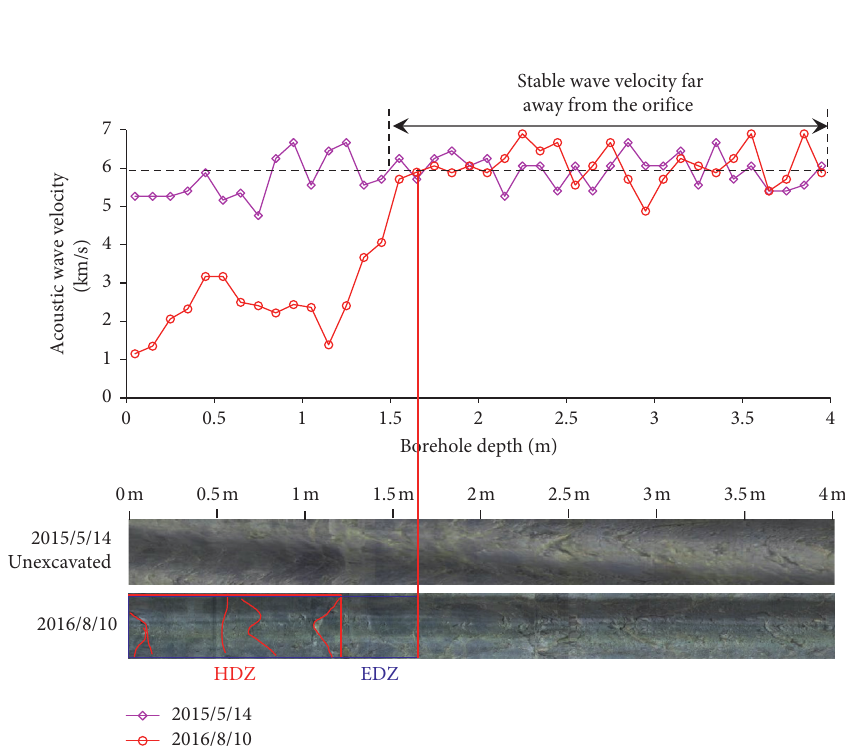
Figure 13: Test results of C-02 in 2# test grotto.